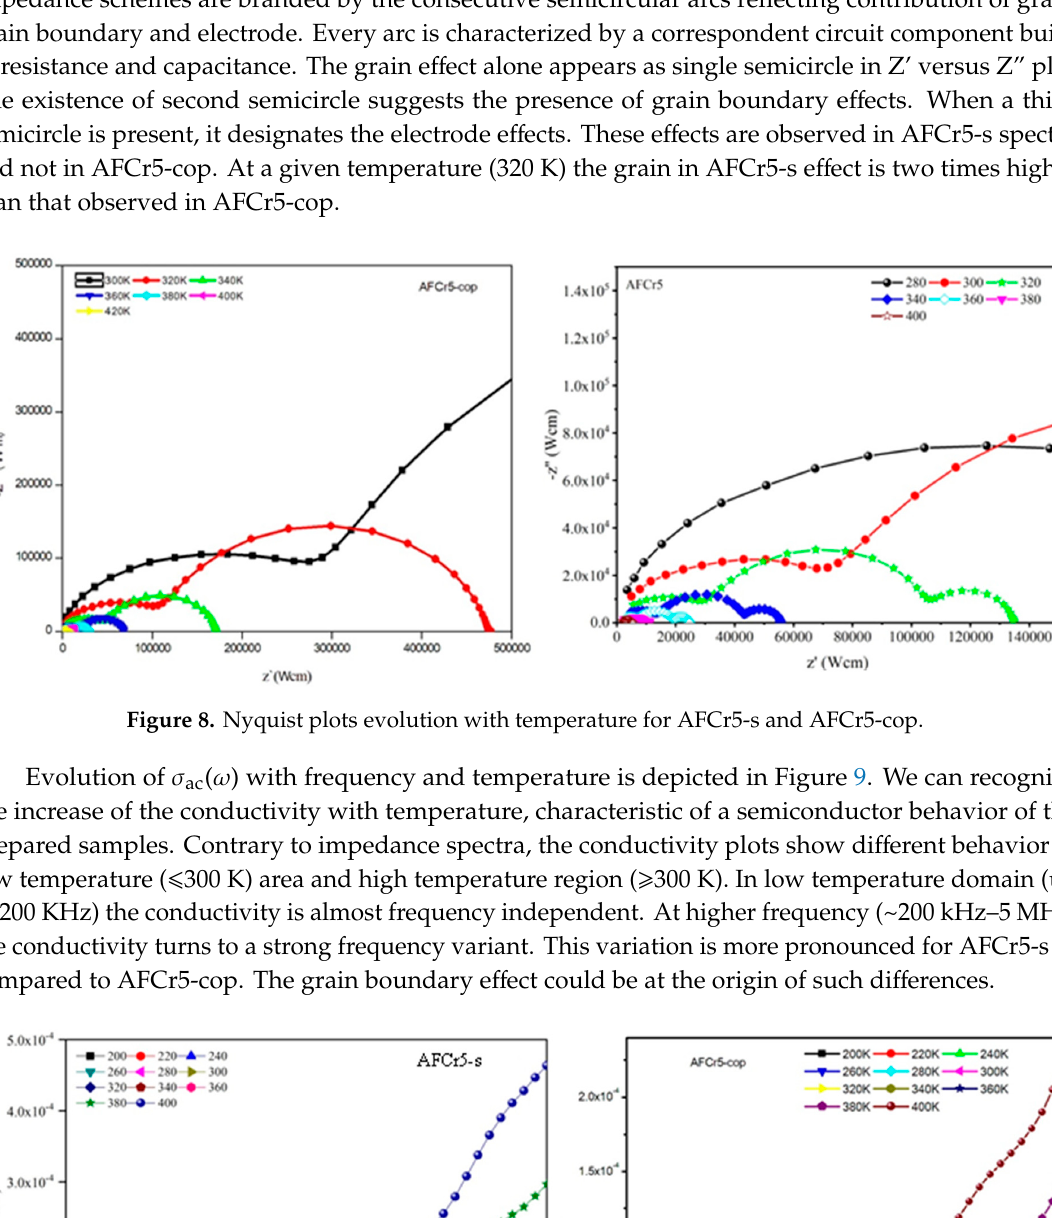
(M”) for AFCr5-s and AFCr5-cop.